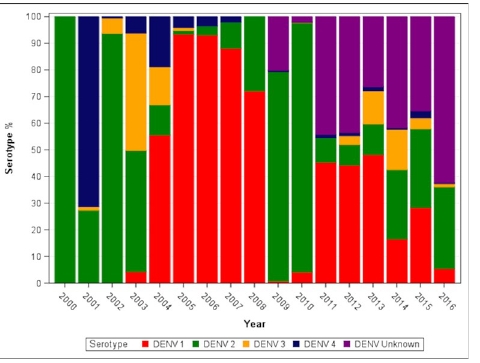
Fig 3. Annual percentage of confirmed dengue cases by serotype. Cases detected by NS1 ELISA but not serotyped are designated DENV